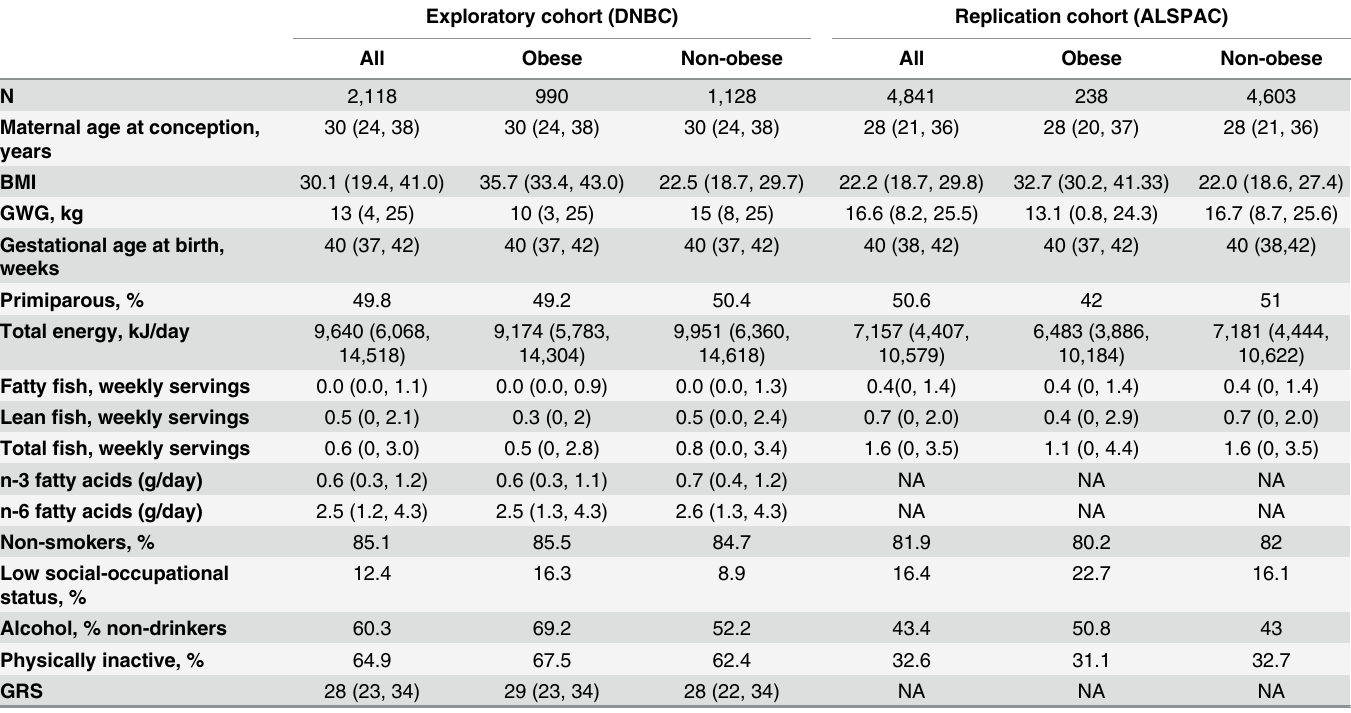
Table 1. Characteristics of all participants, and divided into obese and non-obese. Reported as median (5 – 95 percentiles) unless otherwise